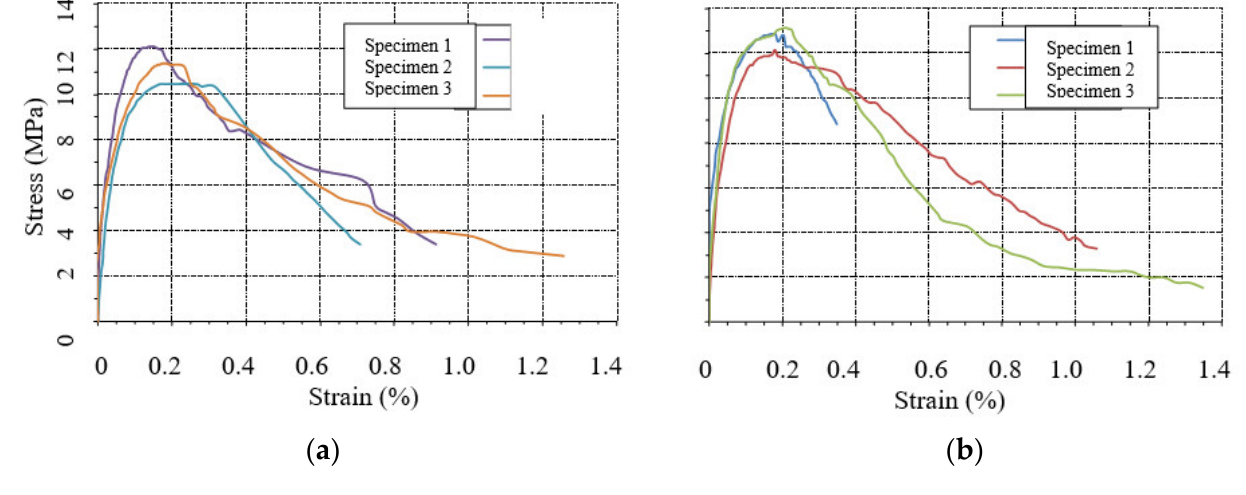
Figure 8. Stress–strain relationships. ( a ) DS-O; ( b ) CCRS-O. Table 3. Standard cylinder and cube test results.